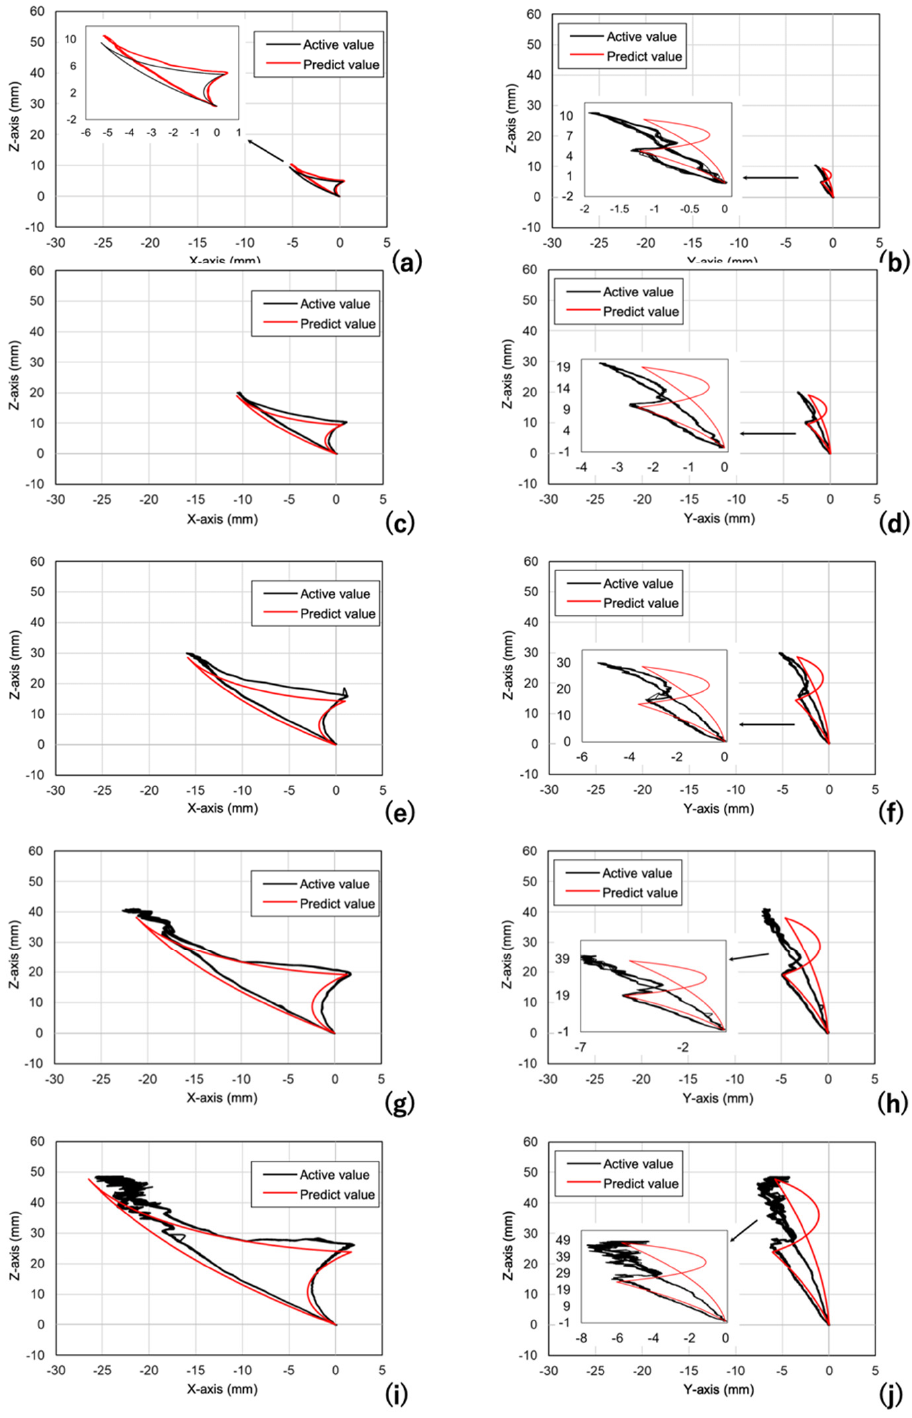
Figure 12. Comparison between the present sensor and the reference instruments. ( a ) Sagittal, 10 mm; ( b ) frontal, 10 mm; ( c ) sagittal, 20 mm; ( d ) frontal, 20 mm; ( e ) sagittal, 30 mm; ( f ) frontal, 30 mm; ( g ) sagittal, 40 mm; ( h ) frontal, 40 mm; ( i ) sagittal, 50 mm; ( j ) frontal, 50 mm.